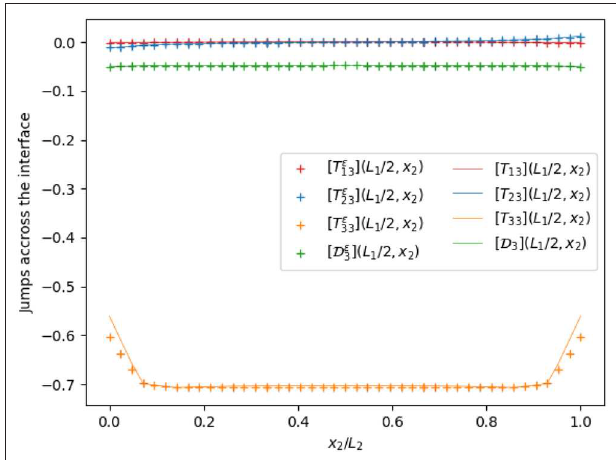
FIGURE 13 | Jumps of the traction vector and normal electric displacement across the interface on a line along the x 2 axis, with ε/ h =